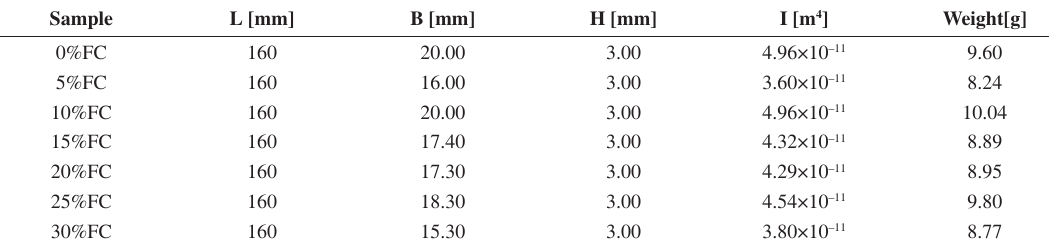
Table 2. Physical and geometrical properties of the specimens.